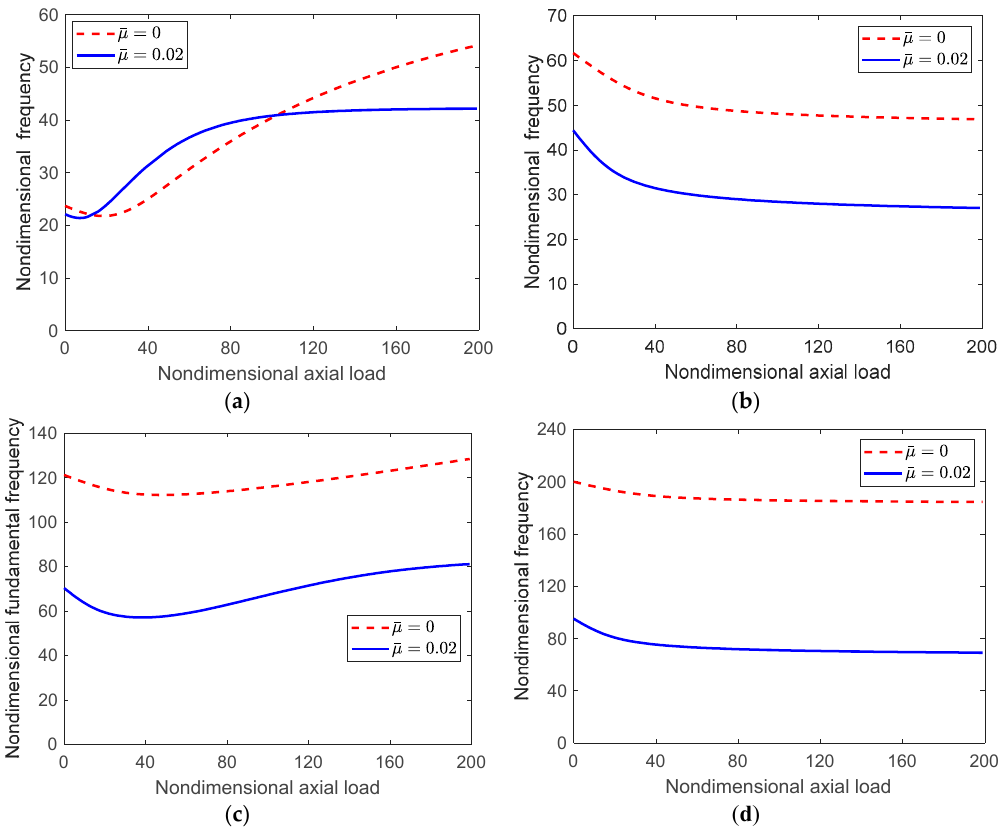
Figure 11. The variation of the first four natural frequencies with the applied axial load for α = 1 of the imperfect nanobeam, a = 1, and µ = ( 0, 0.02 ) . ( a ) The first natural frequency; ( b ) The second natural frequency; ( c ) The third natural frequency; ( d ) The fourth natural frequency.